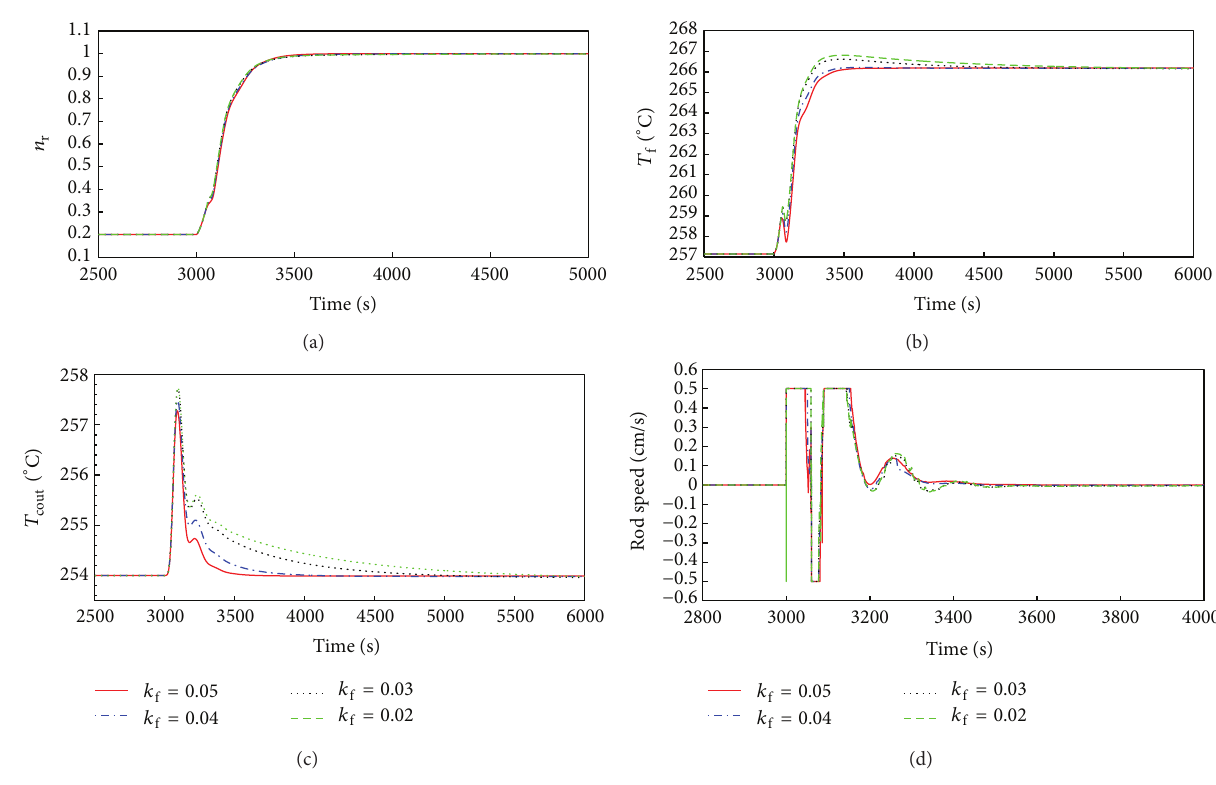
Figure 3: Simulation results in Case